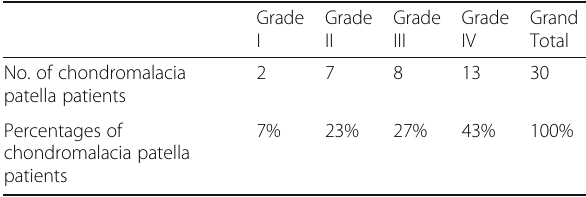
Table 9 Demonstrating the percentage of the prevalence of the different grades of chondromalacia